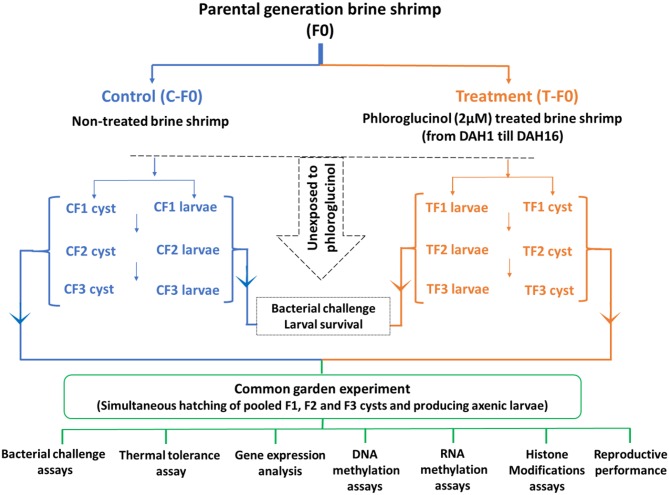
Schematic representation of the experimental setup. For the transgenerational experiment, a total of 2,500 brine shrimp animals in the control and treated population were used. In the treated population, the parental brine shrimp (TF0) were treated with phloroglucinol (2 μM), starting from DAH1 after hatching until DAH16. In the control population, parental shrimp (CF0) were maintained under the same culture and water exchange conditions, but in the absence of phloroglucinol. Adult parental females (CF0 and TF0) produced next-generation CF1 and TF1 larvae and, under suboptimal conditions, CF1 and TF1 cysts. Adult females CF1 and TF1 produced CF2 and TF2 larvae and, under suboptimal conditions, CF2 and TF2 cysts. Subsequently, adult females CF2 and TF2 produced CF3 and TF3 larvae and, under suboptimal conditions, CF3 and TF3 cysts. The F1, F2, and F3 larvae and cysts were never exposed to phloroglucinol. F1, F2, and F3 larvae from treated and untreated parents were subsequently used for V. parahaemolyticus and V. harveyi challenge assays monitoring survival from 12 h until 60 h post infection. For the common garden experiment, all cysts were hatched simultaneously. Then, age- and size-synchronized axenic 1-day old brine shrimp larvae were used for: (i) V. parahaemolyticus and V. harveyi challenge assays (7 replicates at the challenge level with 10 larvae/group) and (ii) a thermal tolerance assay (5 replicates at the challenge level with 20 larvae/group). In addition, for each group, 3 replicates at the challenge level with 100 one-day old larvae before and after challenge (6 and 12 h post infection) and 3 replicates of 5 juveniles (16 days old) were sampled for (iii) gene expression analysis, (iv) DNA methylation assays, (v) RNA methylation assays, and (vi) histone modification assays. Finally, FI, F2, and F3 brine shrimp adults (7 pairs) were examined for reproductive performance, namely, the production of cysts and nauplii.